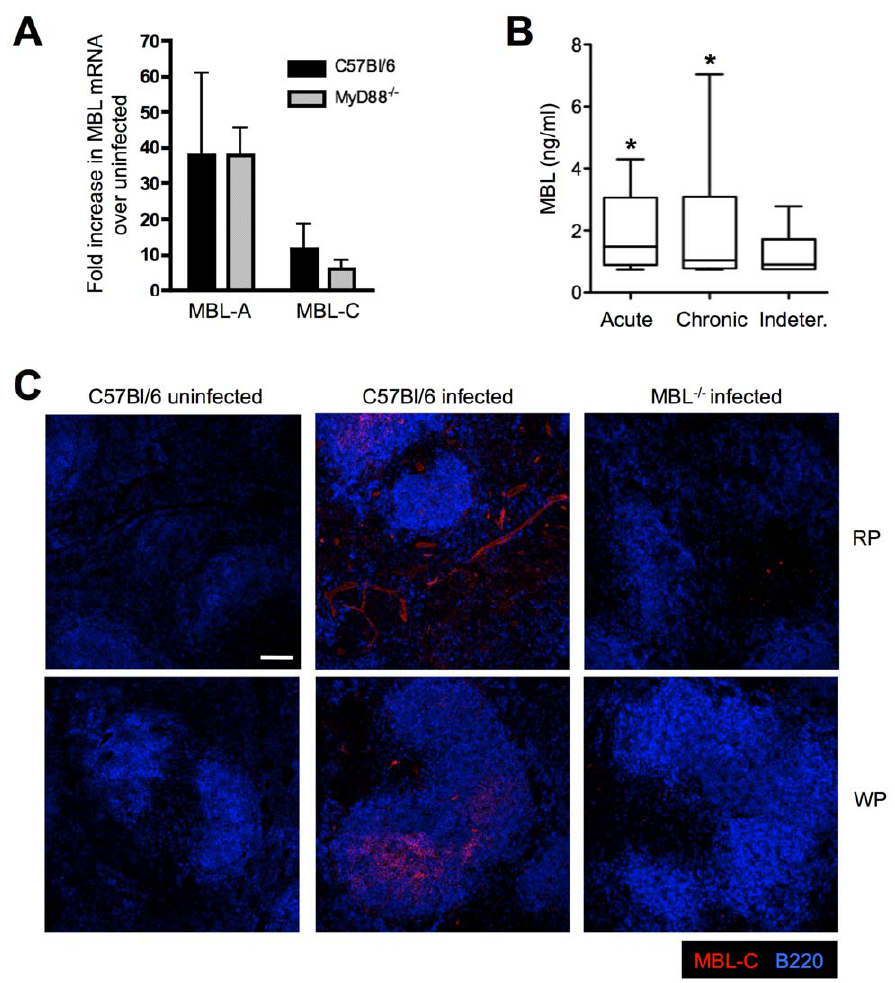
Figure 1. T.cruzi infection induces MBL expression invivo . WT and MyD88 2 / 2 mice were infected with trypomastigotes of the Y strain of T. cruzi and 9 days after infection, MBL-A and MBL-C mRNA accumulation was determined in spleens from infected and uninfected animals by real-time PCR (A). Detection of MBL-C protein was also performed by immunofluorescence microscopy in splenic sections obtained from WT mice infected as above (B). Micrograph shows MBL-C (red) and B220 (blue) staining in both the red (RP) and white pulp (WP). Scale bar, 100 m m. Infected MBL 2 / 2 spleens were included as a control. All panels shown are representative of 2 independent experiments using 3 to 4 mice per group. Bars indicate the standard error of the mean (SEM). Sera from patients with acute, chronic or indeterminate Chagas’ disease were assayed for MBL as described in Material and Methods (C). *, Indicates statistically significant differences between acute vs indeterminate Chagas’ disease groups.